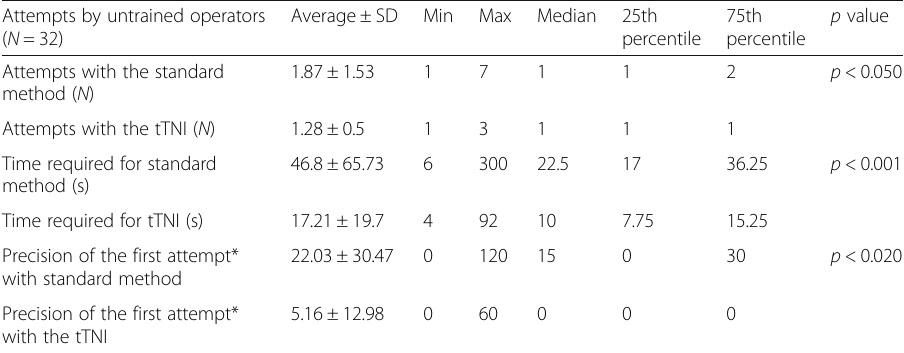
p value 75th percentile percentile